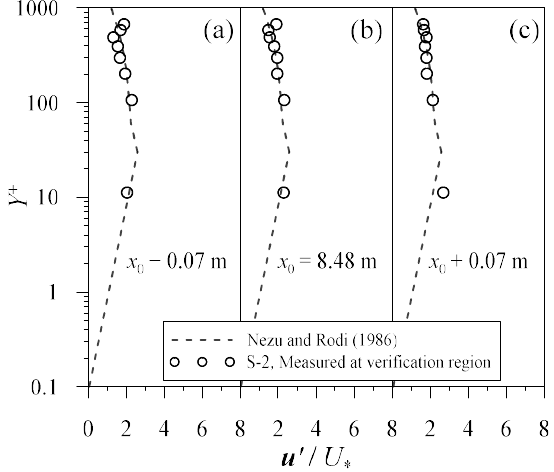
Figure 3. Comparison of the measured dimensionless longitudinal turbulence intensity profiles in the fully developed zone with the empirical profiles presented by Nezu and Rodi [24] at: ( a ) x 0 = 8.41 m, ( b ) x 0 = 8.48 m, and ( c ) x 0 = 8.55